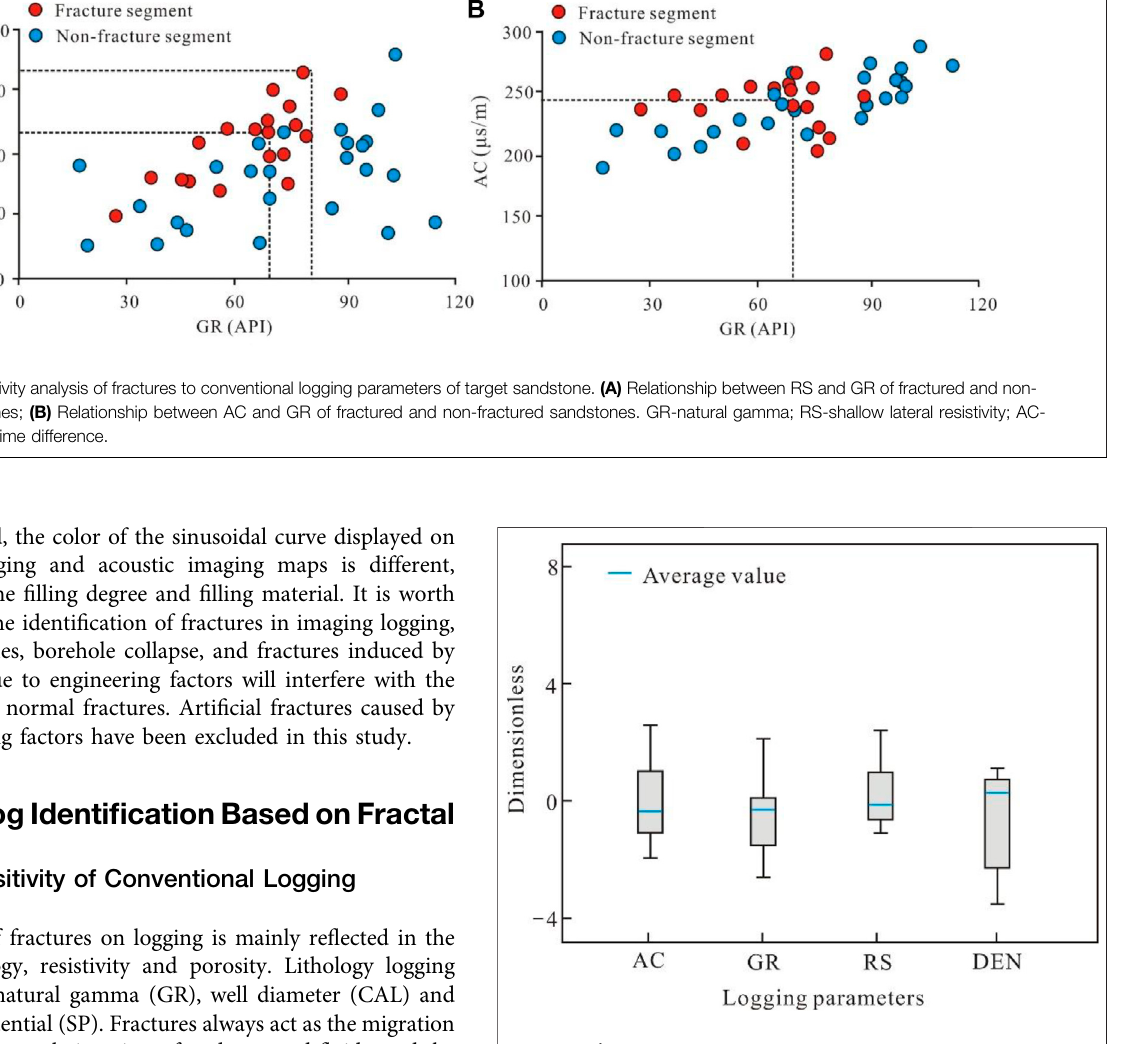
FIGURE 9 | Normalization of raw logging data. AC-longitudinal wave time difference; GR-natural gamma; RS-shallow lateral resistivity; DEN-rock